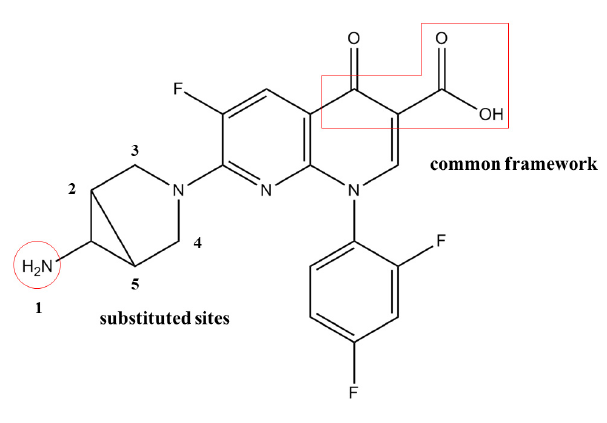
Figure 1. Molecular structure of trovafloxacin.